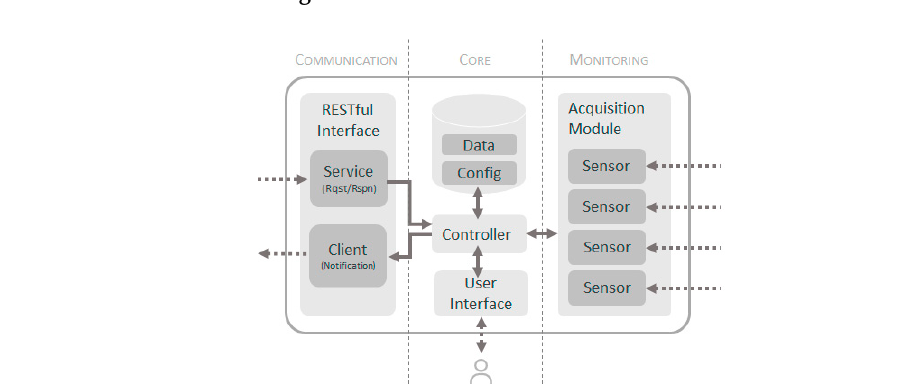
Figure 6. Distribution of sensors on a roof.